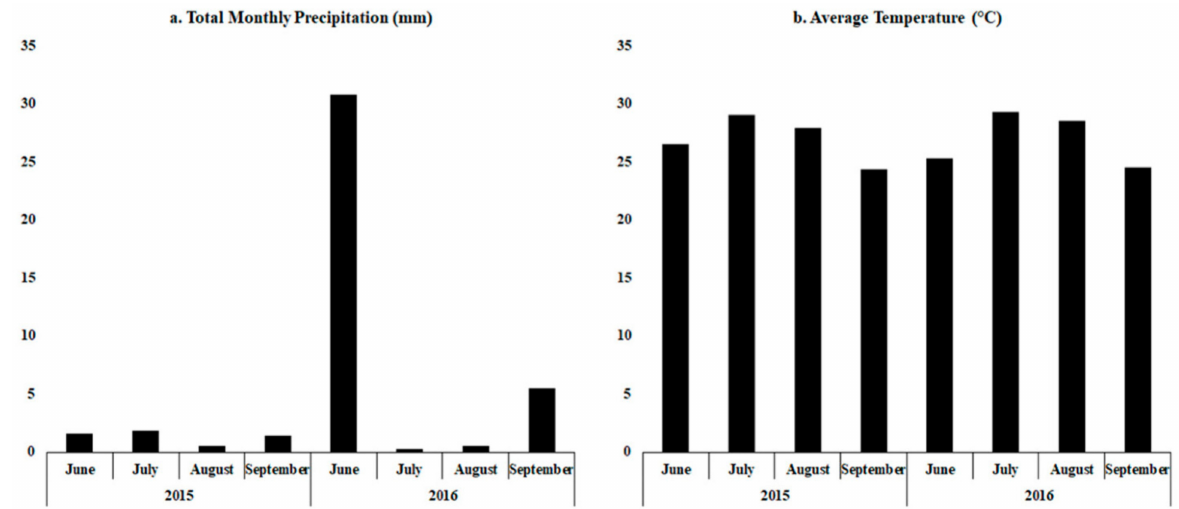
Figure 1. Meteorological data during both cropping seasons: ( a ) monthly precipitation, and ( b ) monthly average